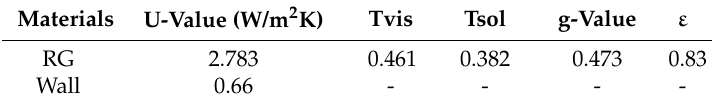
Table 3. Thermal and optical proprieties of the double glazing element RG and the